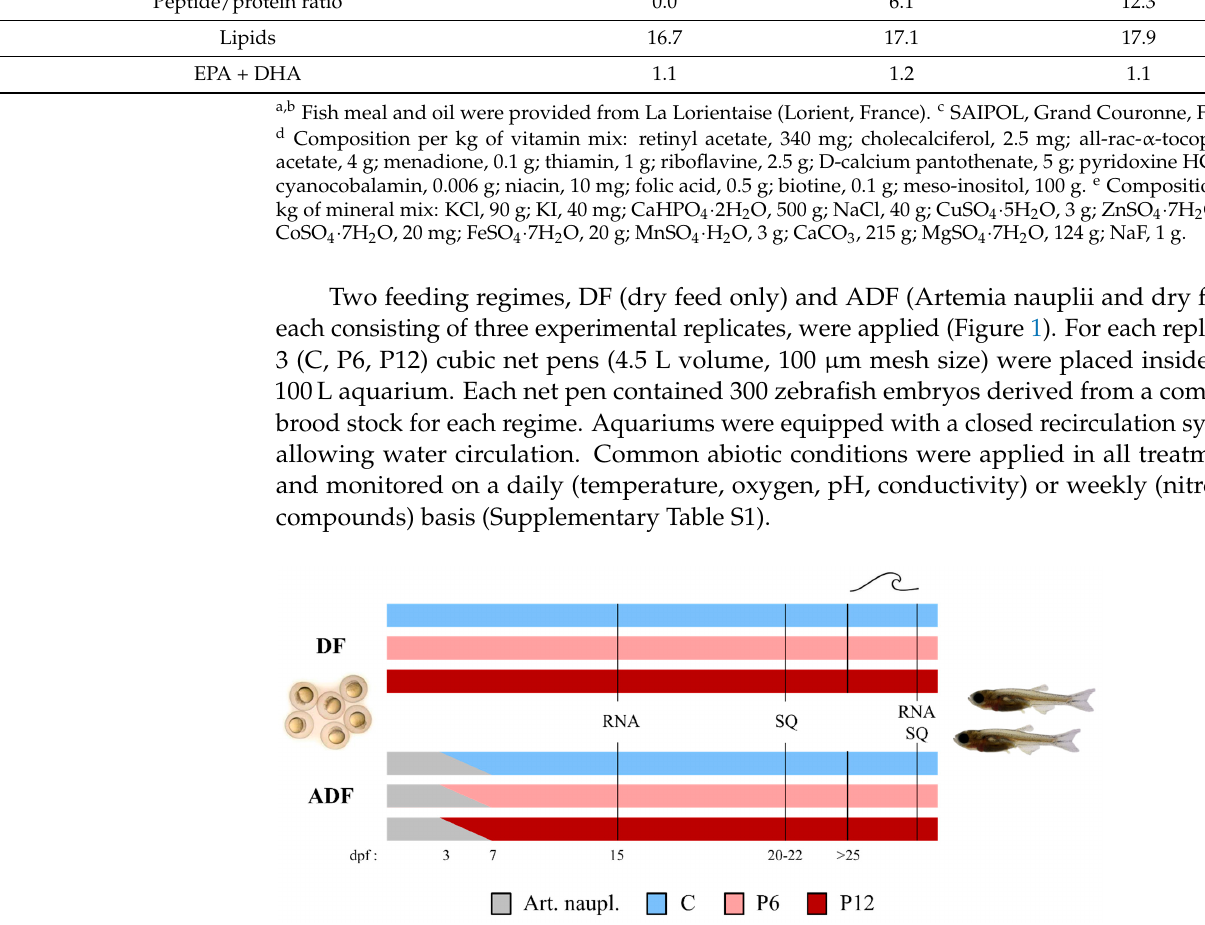
Figure 1. Basic experimental design. Larval rearing was performed under two feeding regimes including (DF) or lacking (ADF) live food supplementation. Three experimental diets (C—Control, P6—6% of dietary peptides and P12—12% of dietary peptides) were tested in triplicate under each feeding regime. Samplings for RNA analysis (RNA) and larval skeletal quality (SQ) took place be- fore and after the swimming challenge test (SCT—marked as a wave symbol). dpf, days post fertili- zation. Art. naupl., Artemia nauplii. In the DF case, larvae were fed fi ve times per day with the experimental diets, from mouth opening until the end of the trial (25–30 dpf, Supplementary Table S2). In the ADF case, a 3-day-exclusive provision of newly hatched Artemia nauplii followed by a 4-day- cofeeding were introduced before a gradual transfer to the experimental dry diets accord- ing to Prin tz i et al. (2021) [8] (Supplementary Table S2). Table 1. Formulation and proximate composition of the experimental diets (C, P6, P12). Ingredients (g kg − 1 , Dry Matter Basis)